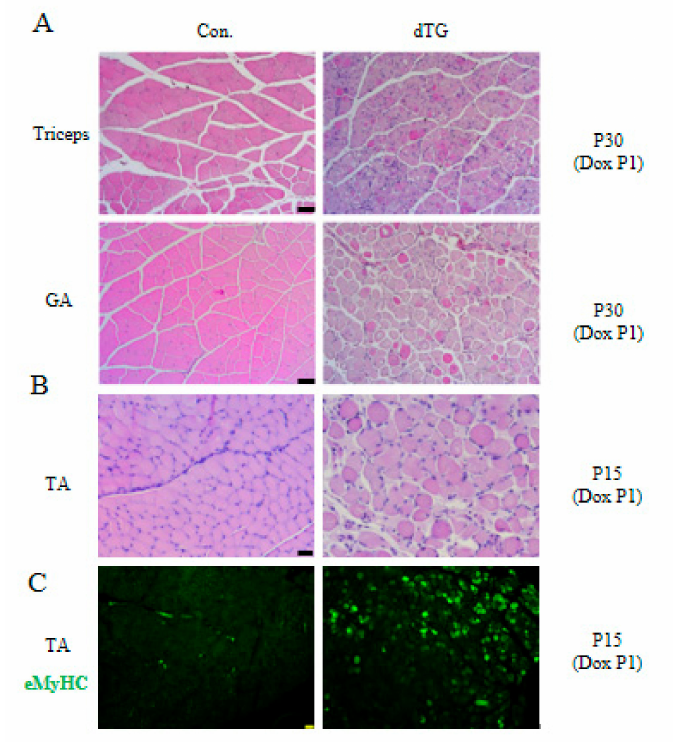
Figure 4. Multiple muscles of dTG mice display injuries. Scale bars: 50 µ m. ( A ) H&E staining of Triceps and gastrocnemius (GA) muscles. ( B ) H&E staining of tibialis anterior (TA) muscles. ( C )